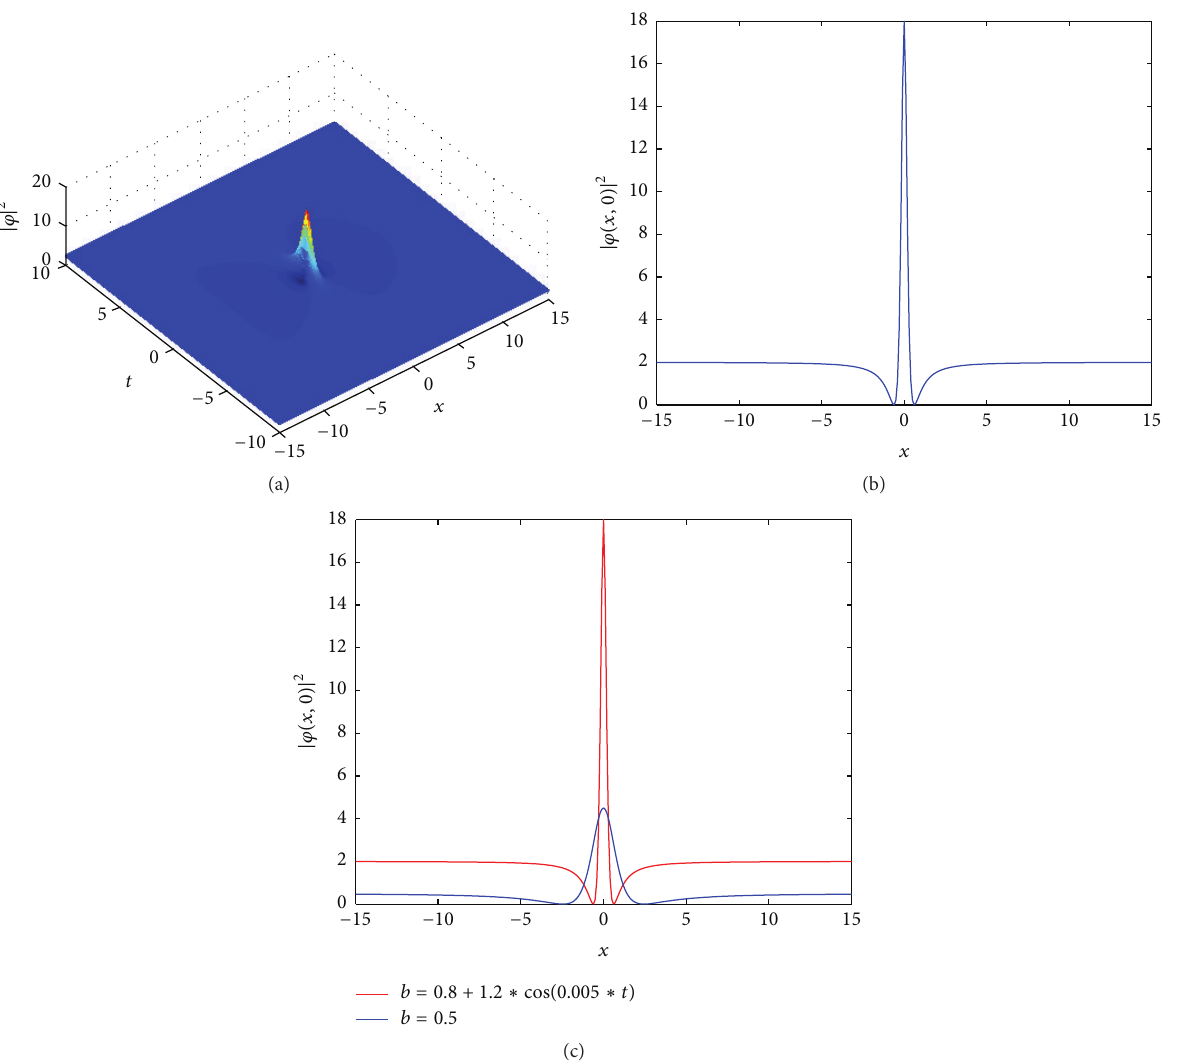
Figure 5: (a) The first-order rogue wave propagations for the intensity |𝜑| 2 with the gravity field and external magnetic field 𝑏 = 0.8 + 1.2 cos (0.005𝑡) and 𝛽 = 0.2𝑡 2 . (b) Rogue wave propagations for the intensity |𝜑(𝑥,0)| 2 with 𝑡 = 0 . (c) The comparison of the amplitude between 𝑏 = 0.8 and 𝑏 = 0.8 + 1.2 cos (0.005𝑡) .